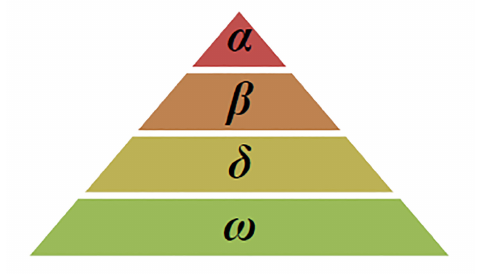
Figure 5. Grey wolf